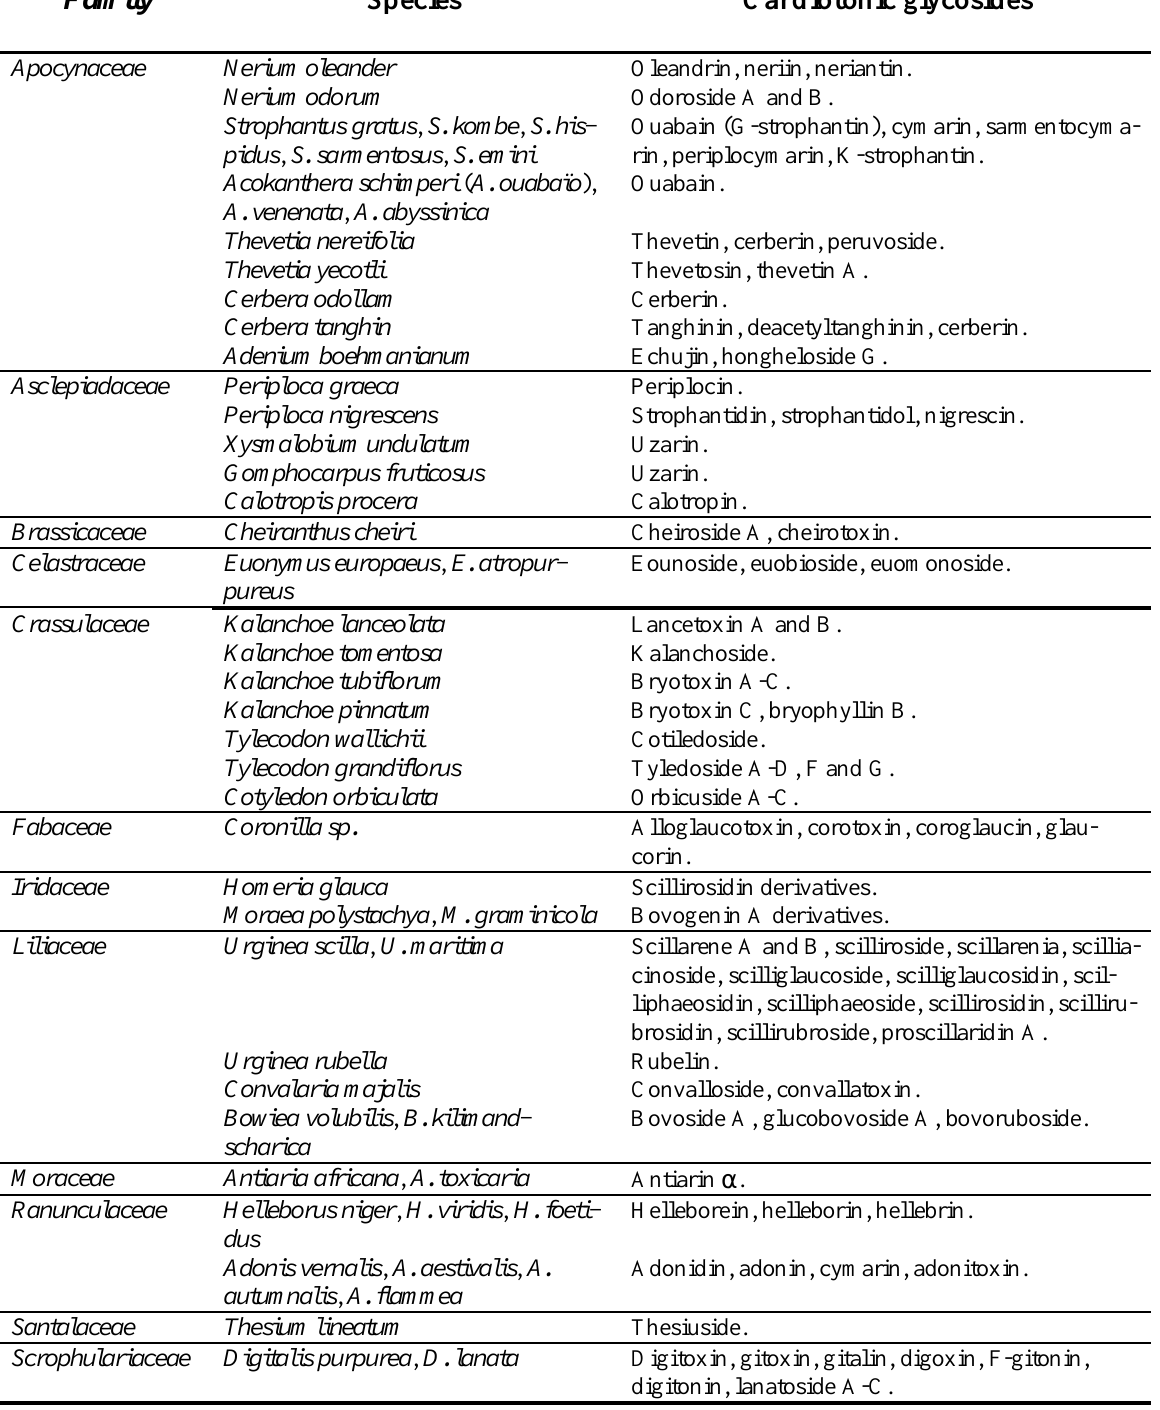
Table 1. Fanerogam species containing digitalis-like